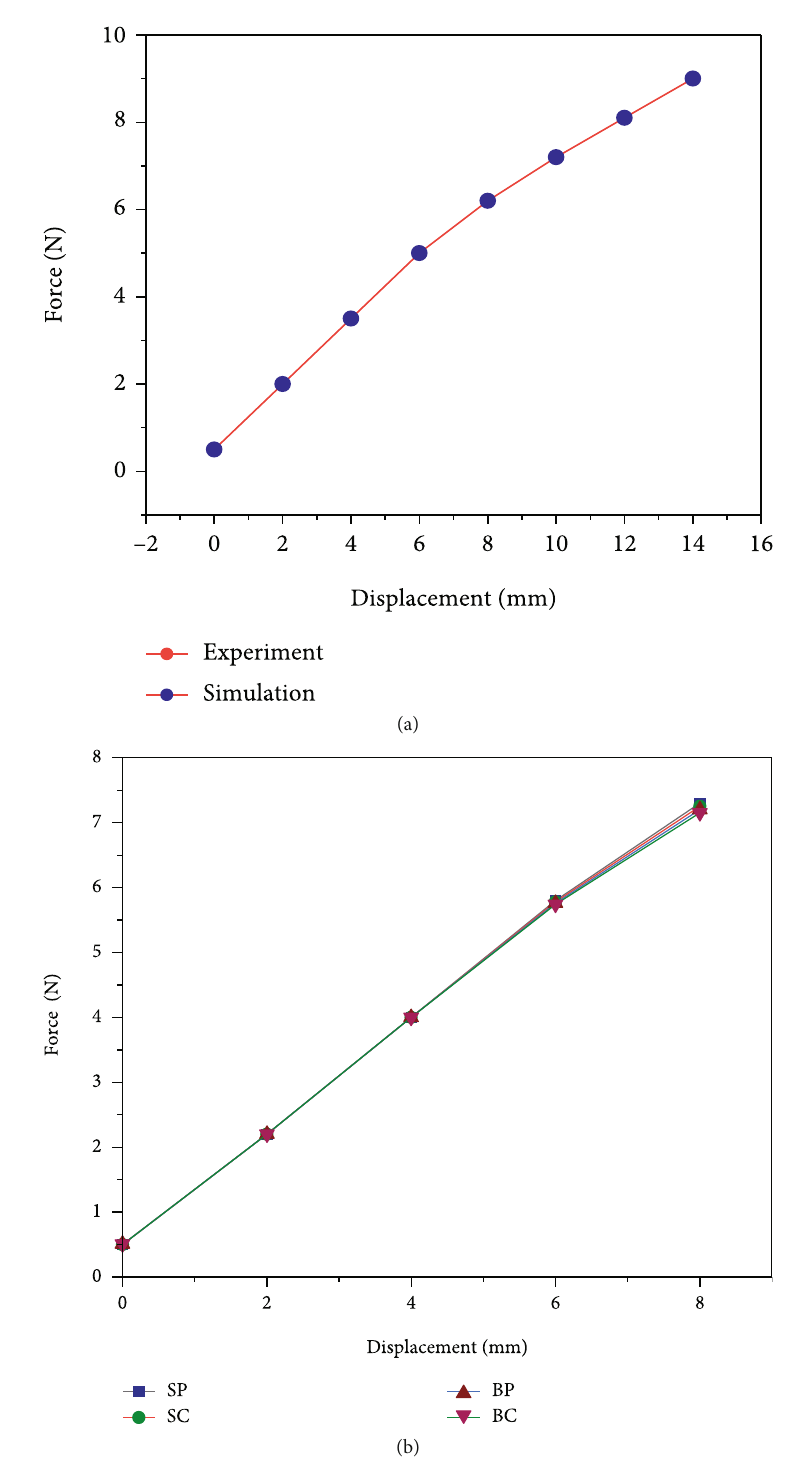
Figure 5: The rollers ’ force vs. displacement curves. The comparison of the (a) SP con fi guration specimen in simulation and experiment and (b) all con fi gurations in the